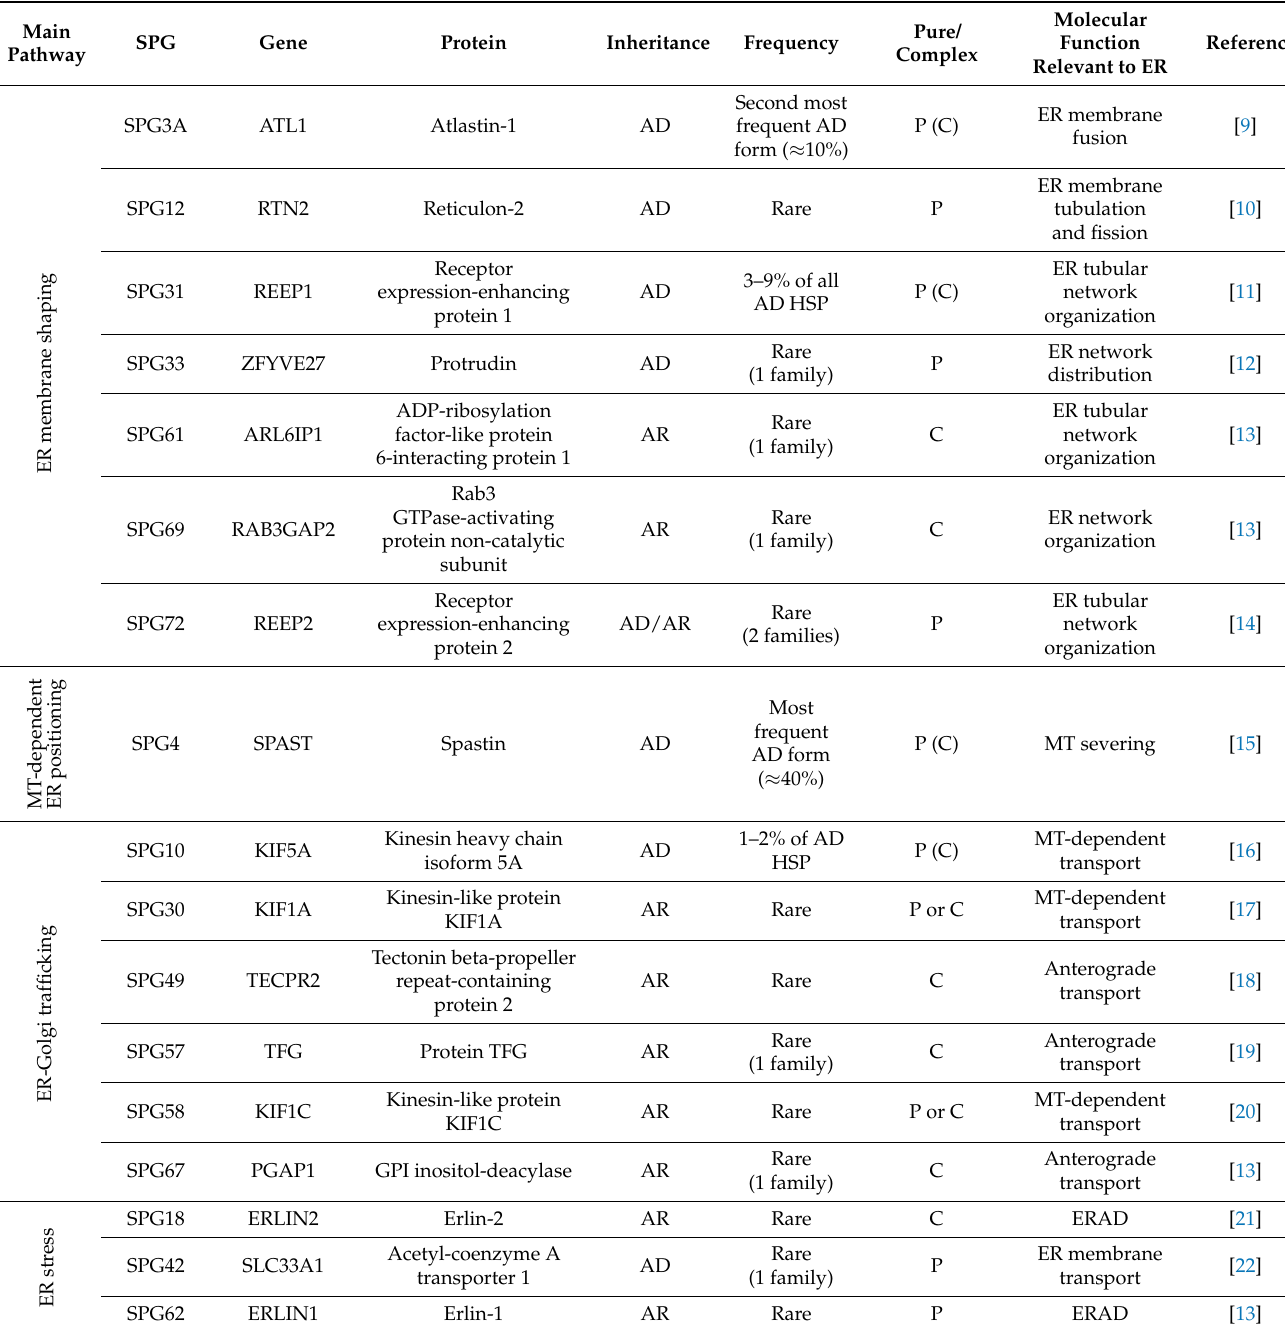
Table 1. HSP genes with established (or proposed) role in the maintenance of ER shape/function (MT, microtubule; P, pure; C,